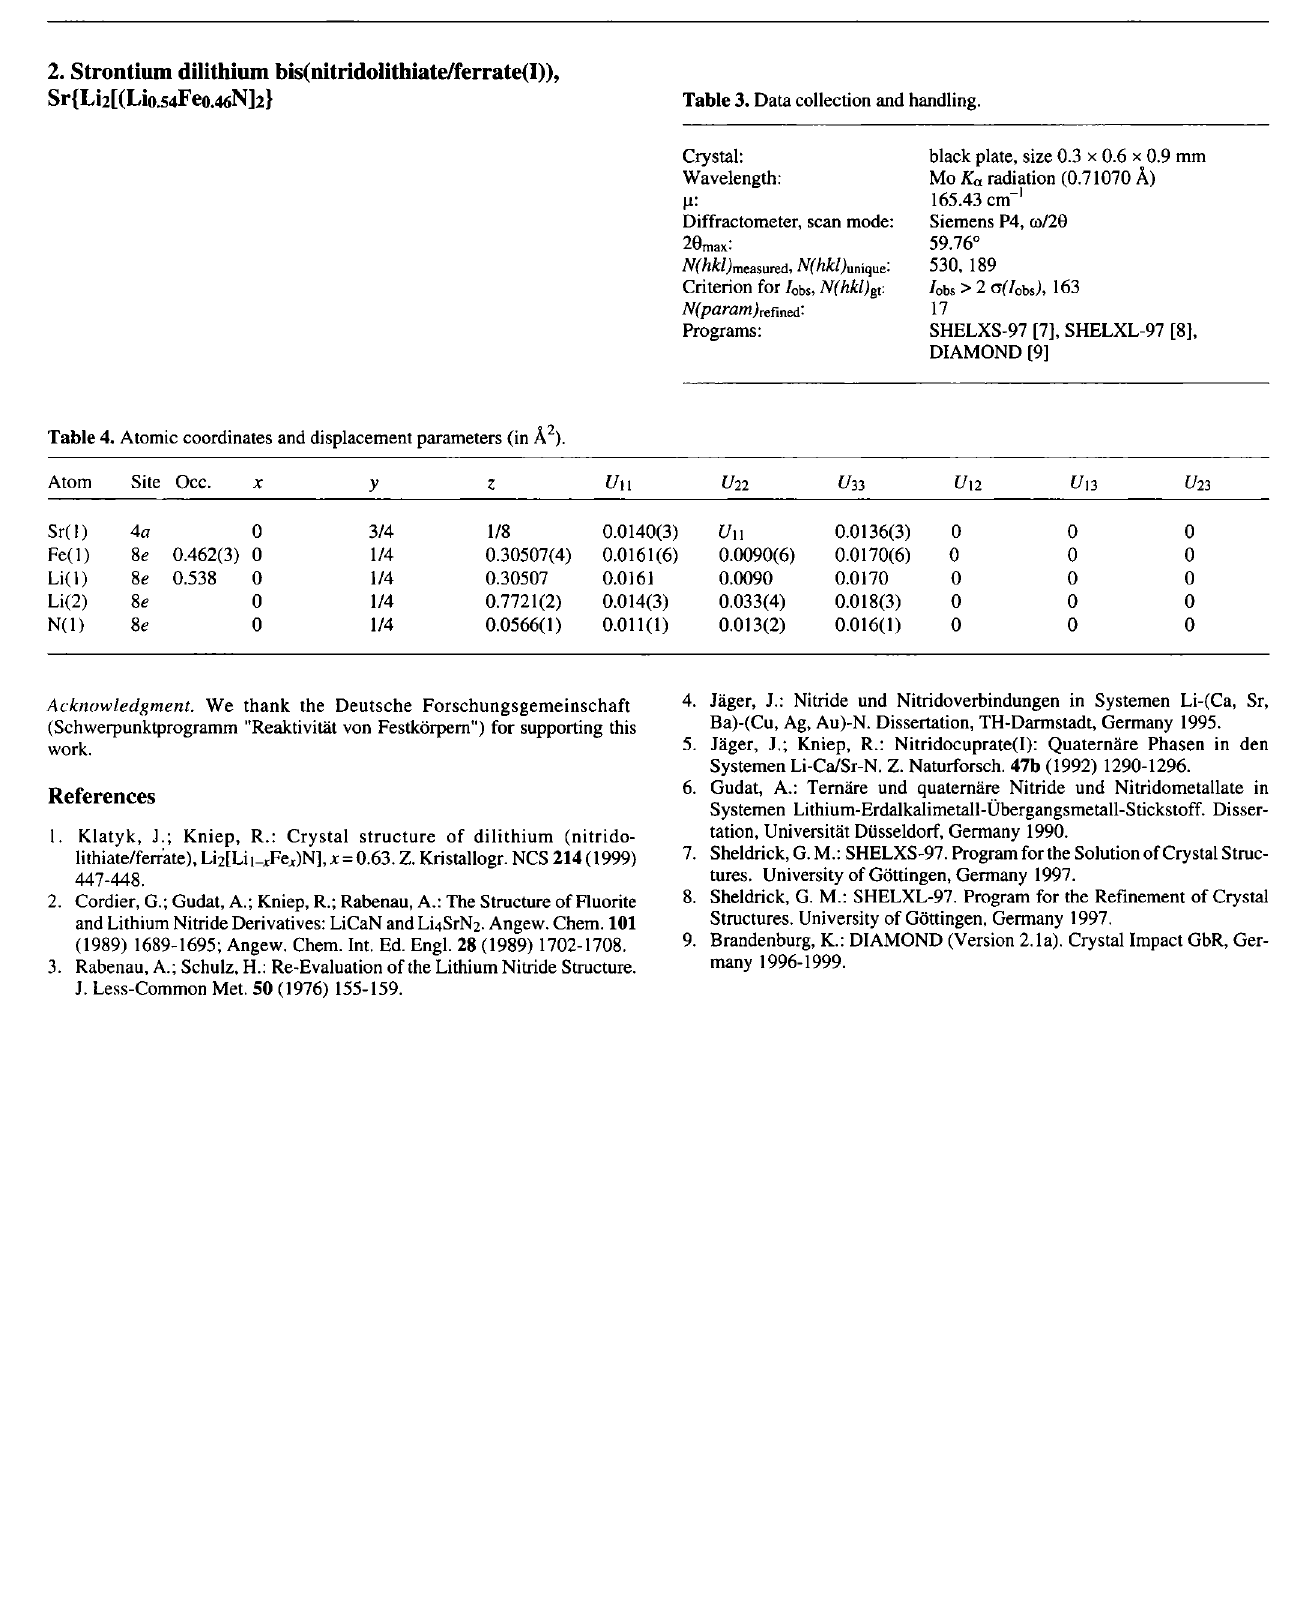
Table 3. Data collection and handling. Crystal: